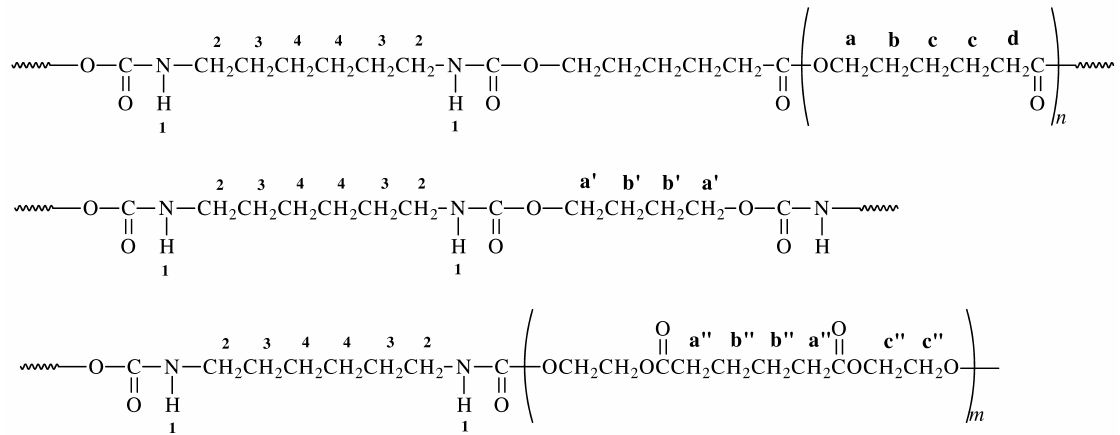
Figure 2. Structure of the obtained